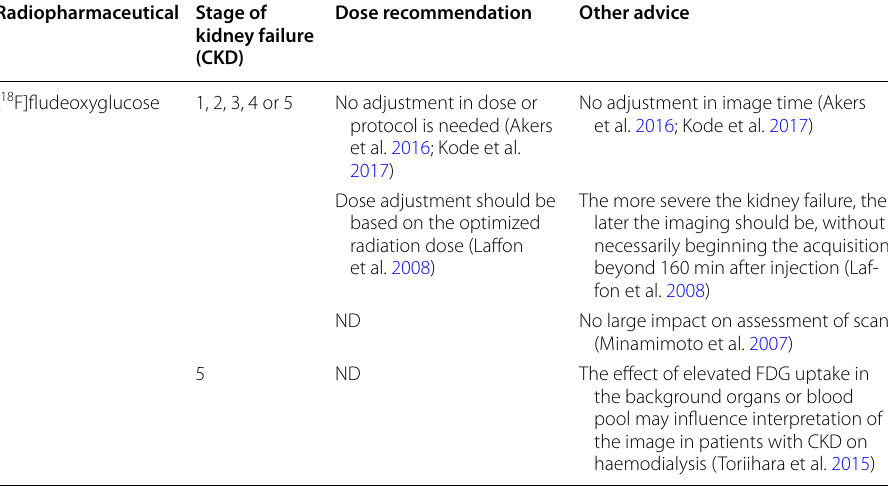
CKD, chronic kidney diseases; FDG, [ 18 F]fludeoxyglucose; ND, ‘not determined’